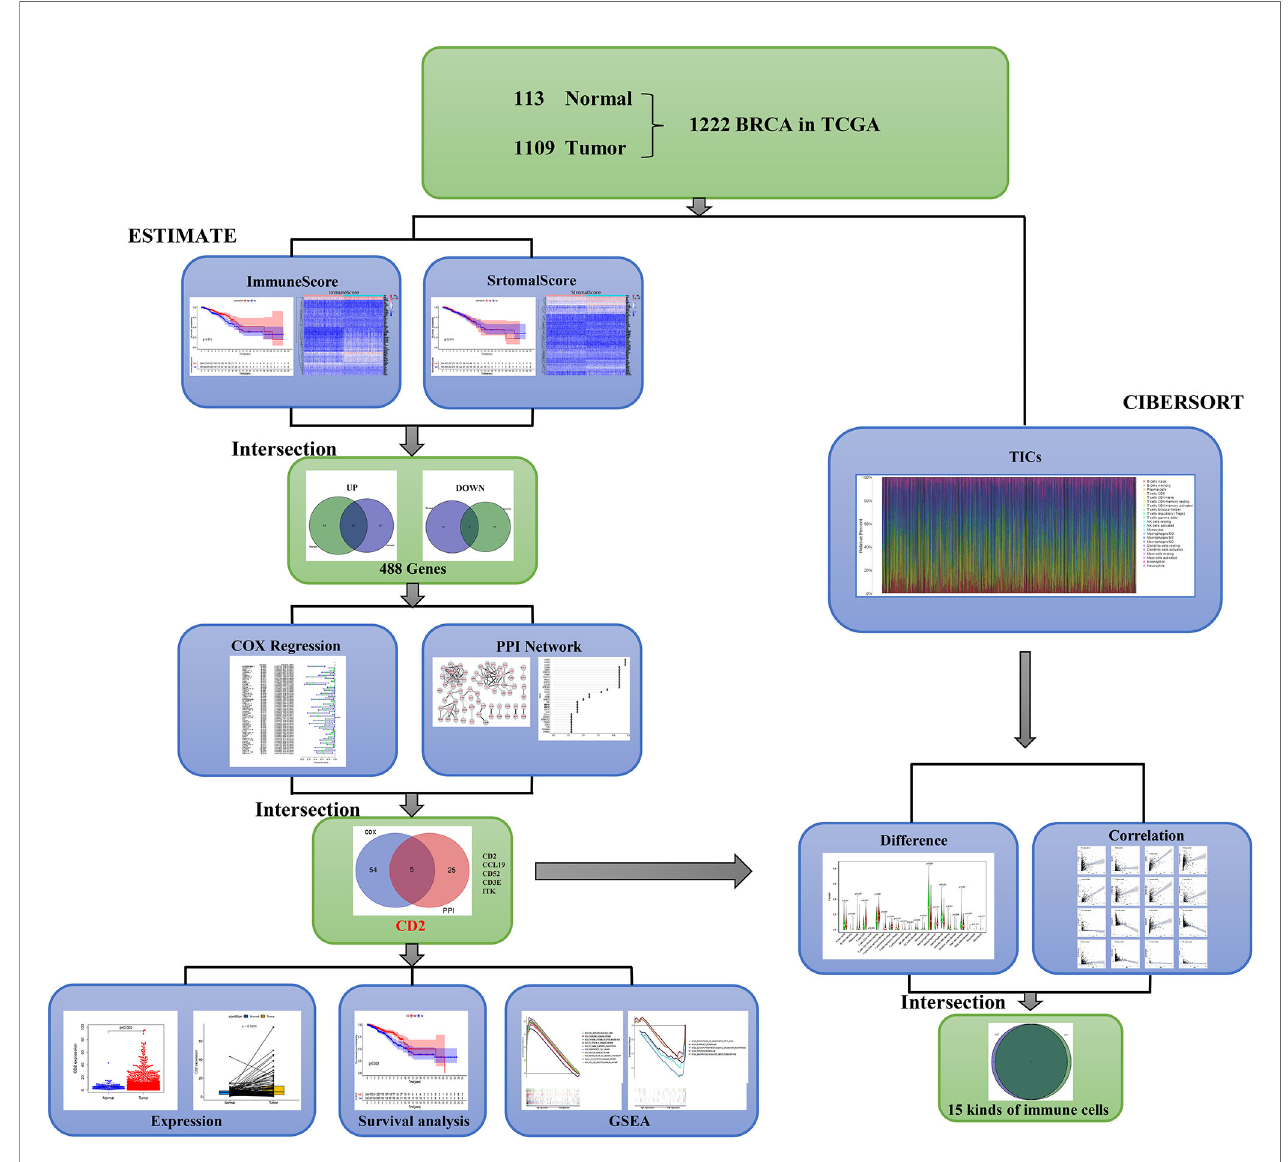
FIGURE 1 | Analytical fl owchart of this